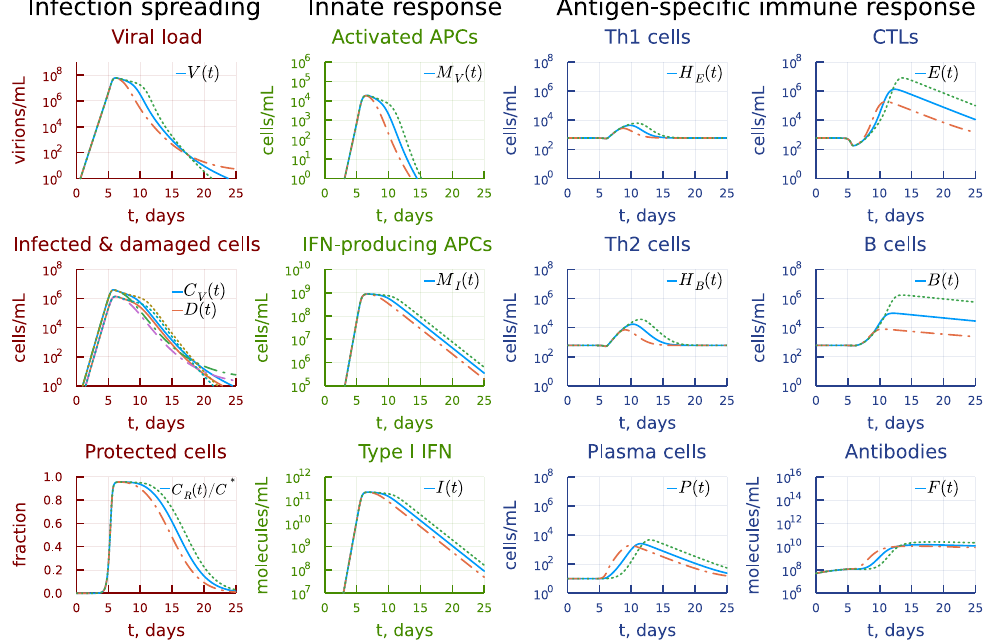
Figure 13. Effect of the differentiation rate constant of antigen-specific B cells into plasma cells. Dashdot: 10-fold increase of b P p , dot: 10-fold decrease of b P p relative to baseline